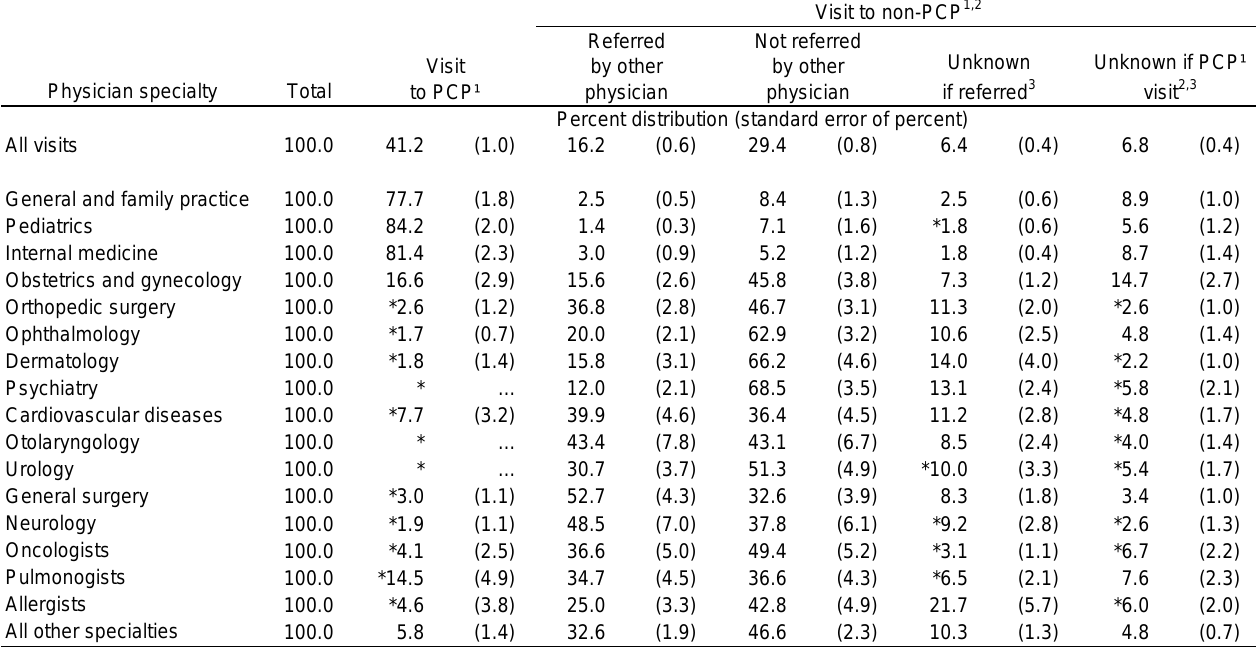
Table 9. Primary care provider and referral status, by physician specialty: United States,